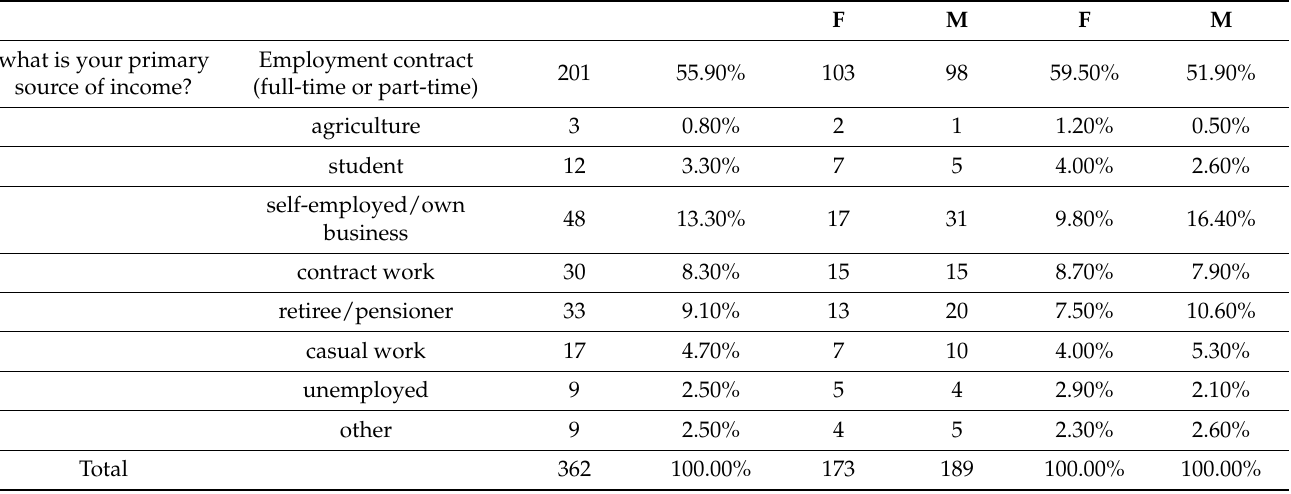
Table 4. Sources of